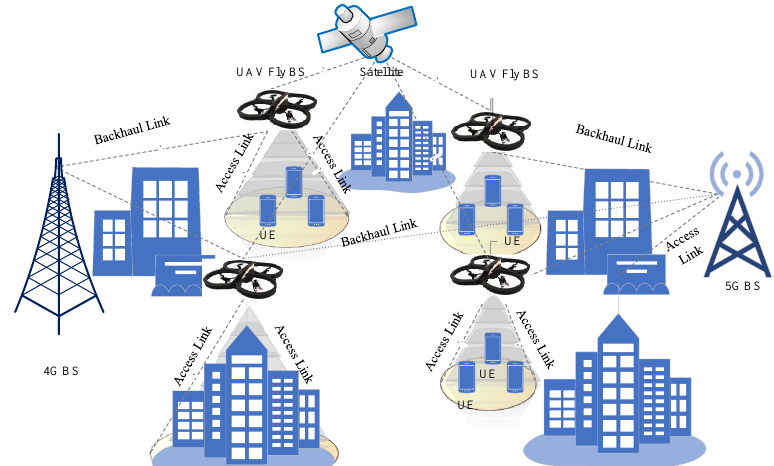
Figure 4. UAVs as base stations in a future ultra–dens heterogenous network.